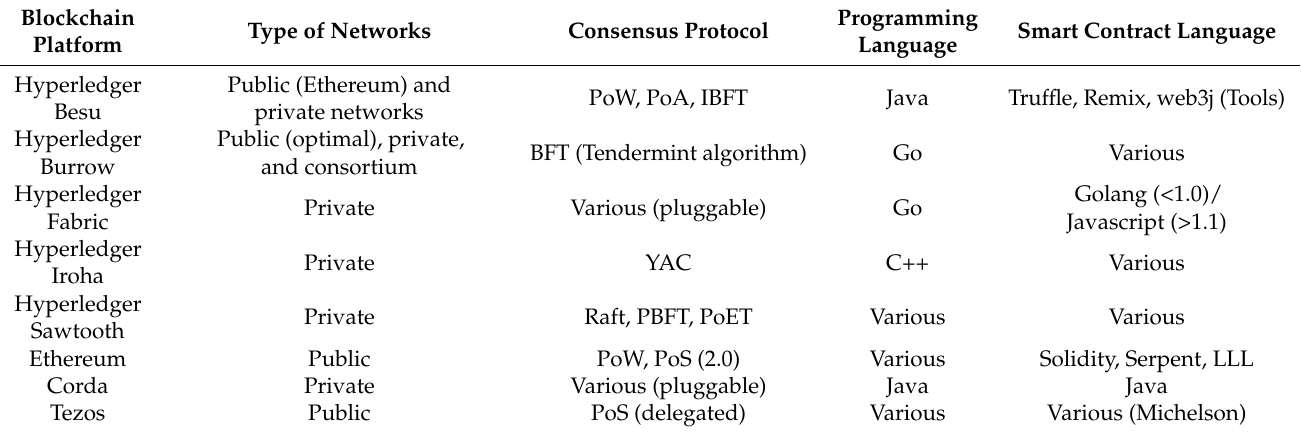
Table 4. Comparison of Blockchain